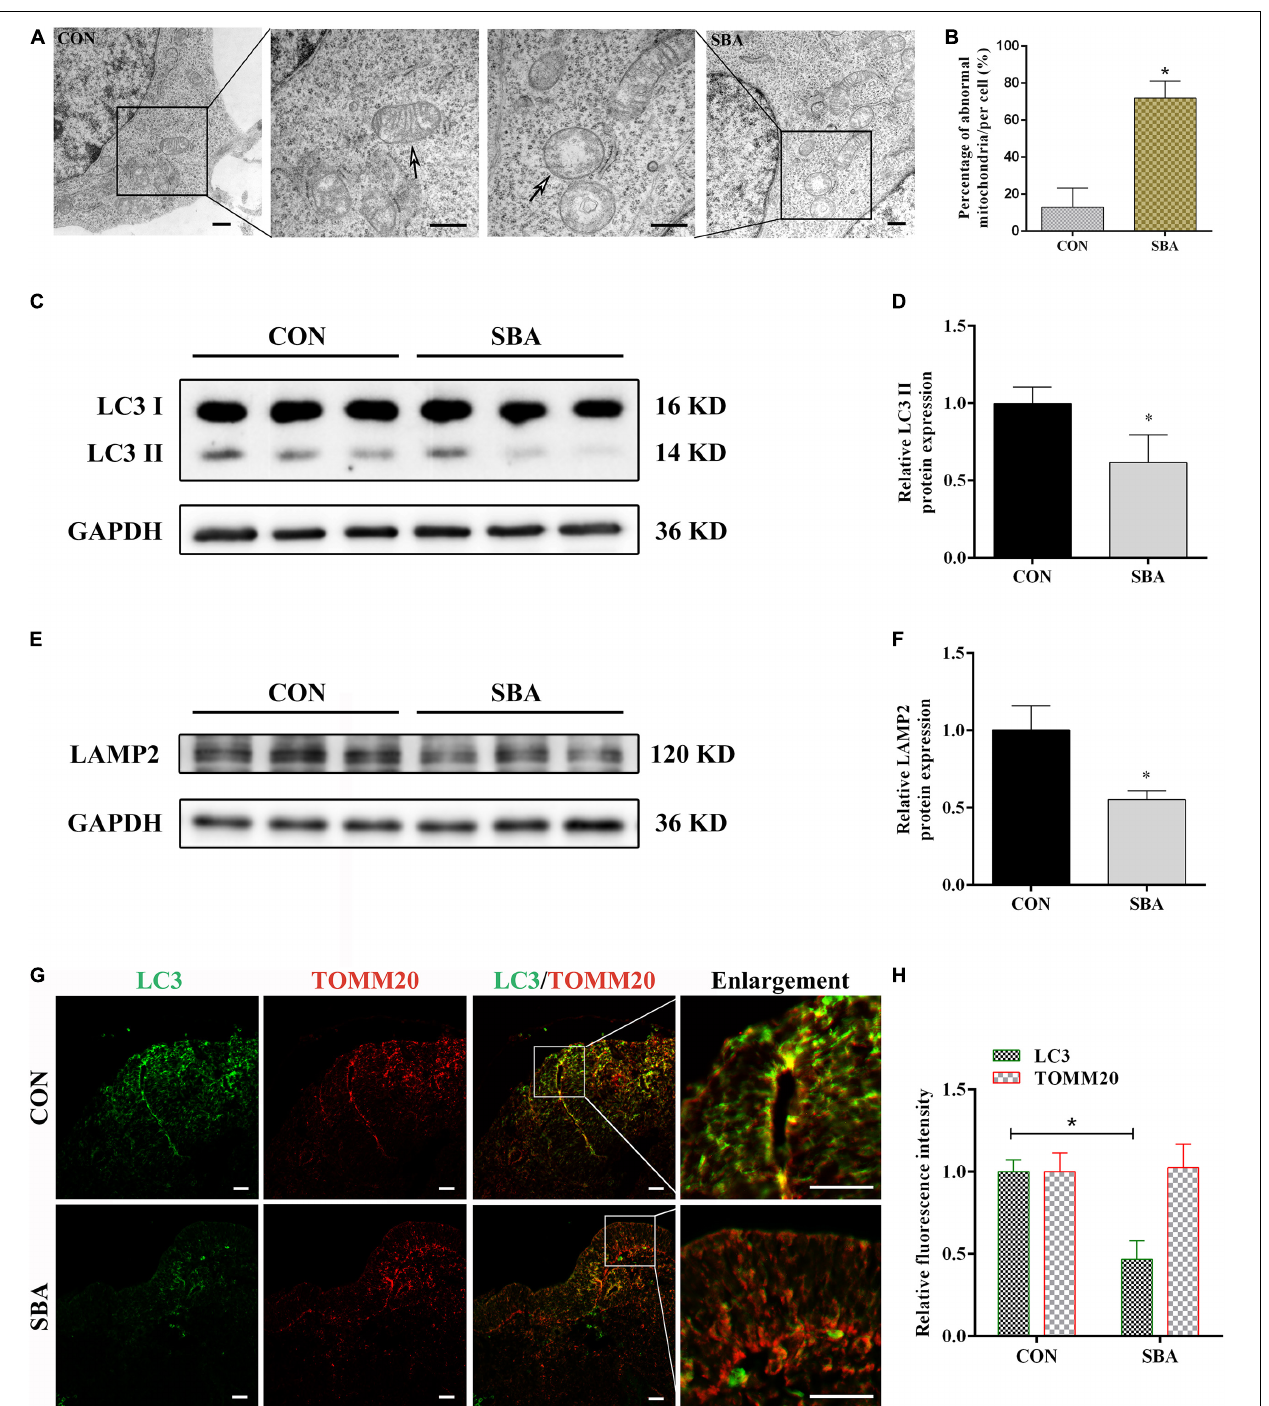
FIGURE 1 | Autophagy and mitophagy in SBA rat embryos. (A) TEM detection of mitochondria in the neuroepithelium of spinal cords of rat embryos of the CON and SBA groups. Arrows indicate mitochondria. Scale bar = 500 nm. (B) Defective mitochondria rates in neuroepithelial cells from E12 embryos. Defective mitochondria rate = number of defective mitochondria divided by total number of mitochondria. (C) Western blot showing LC3 expression in rat embryonic spinal cord tissues in the CON and SBA groups. (D) Quantitation of LC3 II expression ( n = 6). (E) Western blot showing LAMP2 expression in rat embryonic spinal cord tissues in the CON and SBA groups. (F) Quantitation of LAMP2 expression ( n = 6). (G) Double immunofluorescence staining with LC3-labeled autophagosomes (green) and TOMM20-labeled mitochondria (red) in rat embryonic spinal cords. Scale bar = 10 µ m. (H) Relative fluorescence intensities of LC3 and TOMM20 in the SBA group versus the CON group ( n = 4). Results are expressed as the mean ± SD. * p < 0.05 vs. control group.